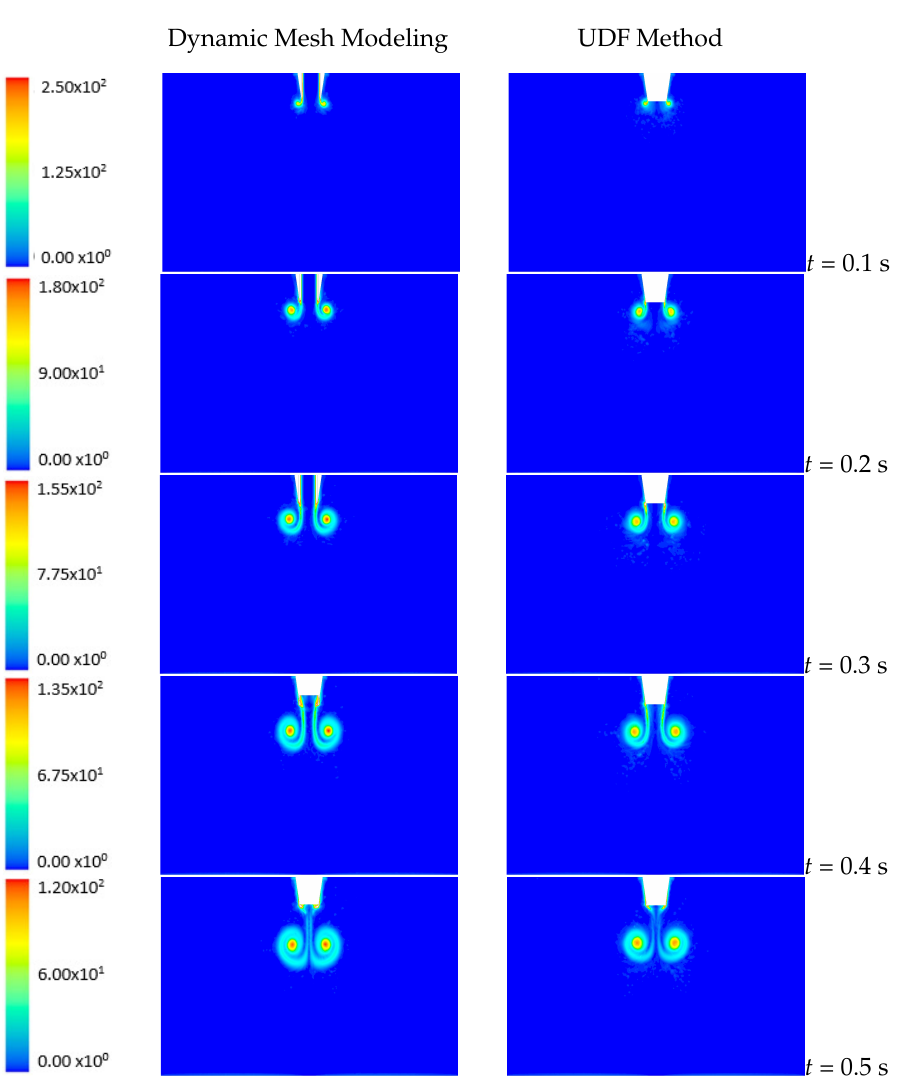
Figure 4. Vortex ring generation and vorticity contours (1/s): dynamic mesh modeling vs. UDF